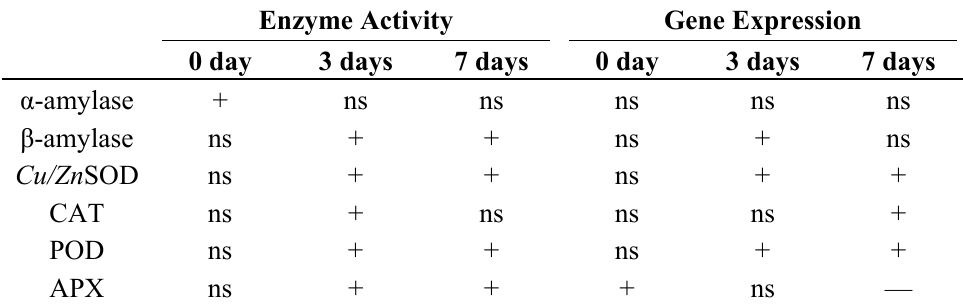
Table 3. The relationship between the enzyme activities and gene expressions of enzymes; α -amylase, β -amylase, Cu/ZnSOD, CAT, POD and APX in the process of seeds germination, submitted to water stress induced by 15% PEG for 0 day, 3 days and 7 days. “+” induced; “—” suppressed; “ns”, not significantly changed as compared with seeds priming with water (control) according to SE at p ≤